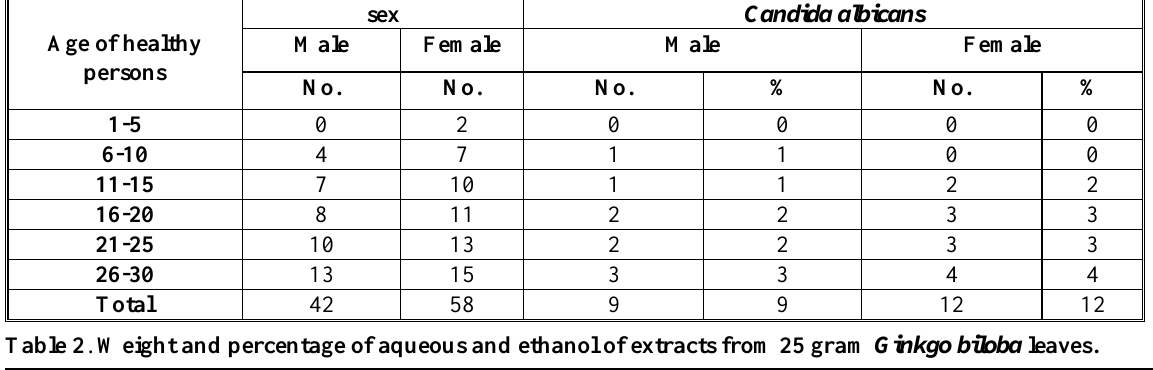
Table 1. The presence of C. albicans in male and female according to their age. Age of healthy